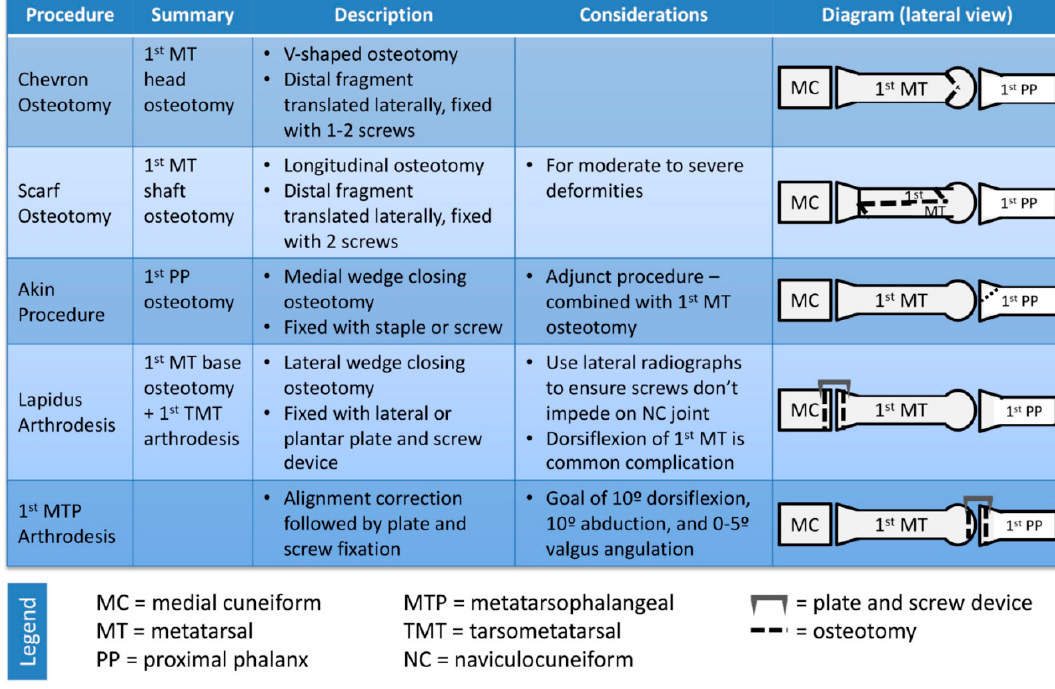
Figure 2. Surgical options for correction of hallux valgus.